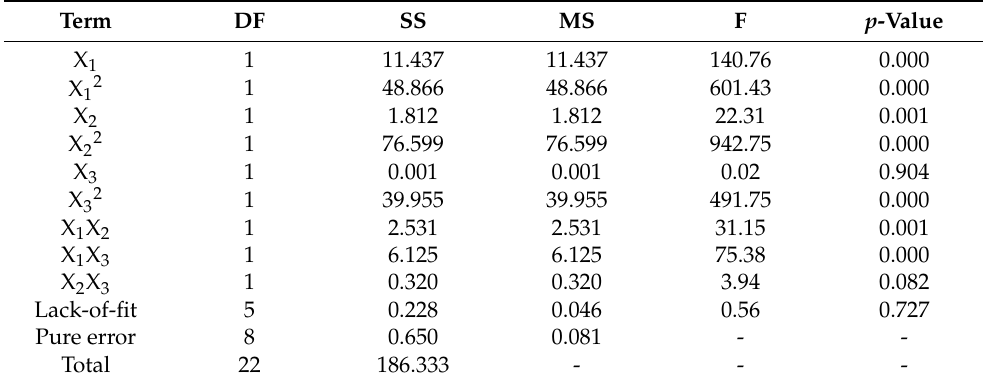
Table 5. ANOVA table for the CEC using central composite